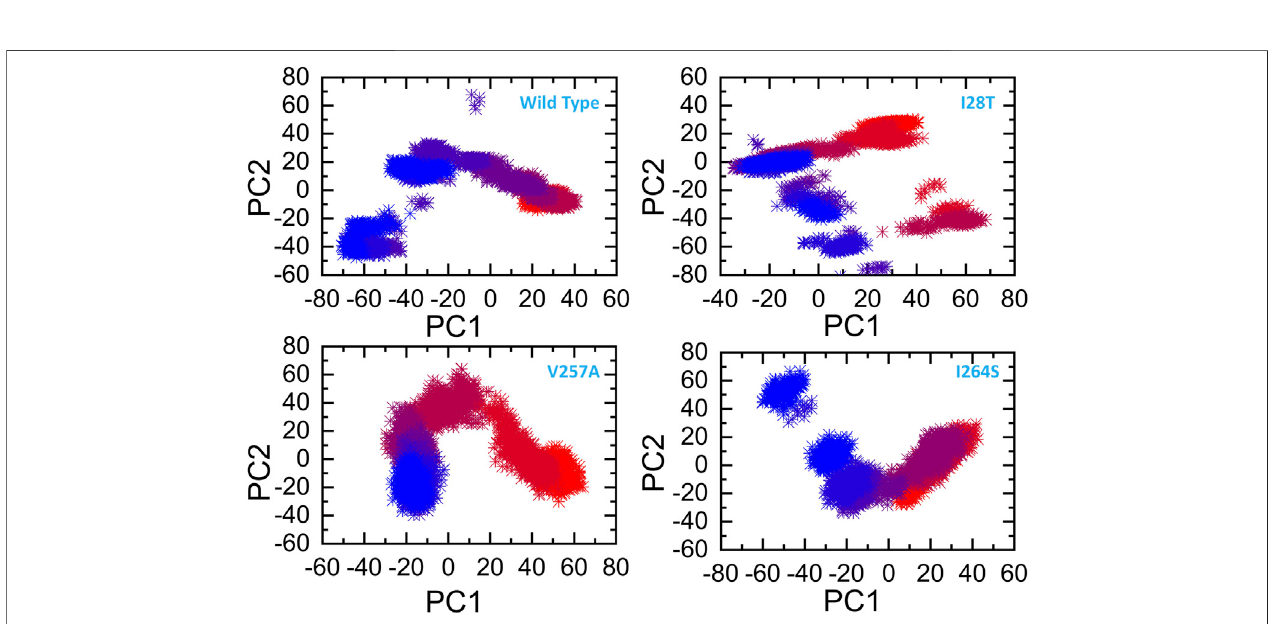
Frontiers in Molecular Biosciences |